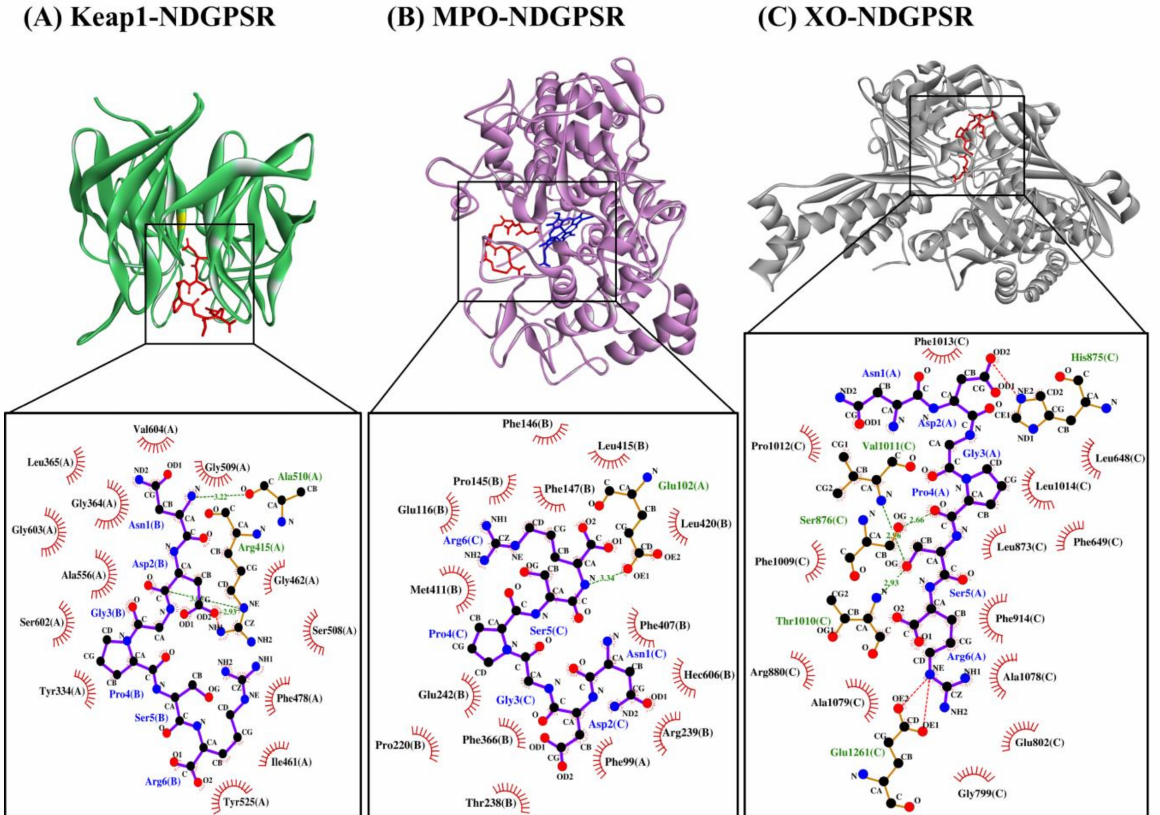
Figure 4. The docked models of NDGPSR interacting with ( A ) Keap1, ( B ) MPO, and ( C ) XO in 3D (top) and 2D (bottom) diagrams. In the 3D diagrams, NDGPSR is displayed in red; the heme moiety of MPO in ( B ) is displayed in blue. In the 2D diagrams, bonds of proteins are in orange, whereas those of peptides are in purple. Hydrophobic interactions, hydrogen bonds, and salt bridges are represented in red spoked arcs, green dashed lines, and red dashed lines,